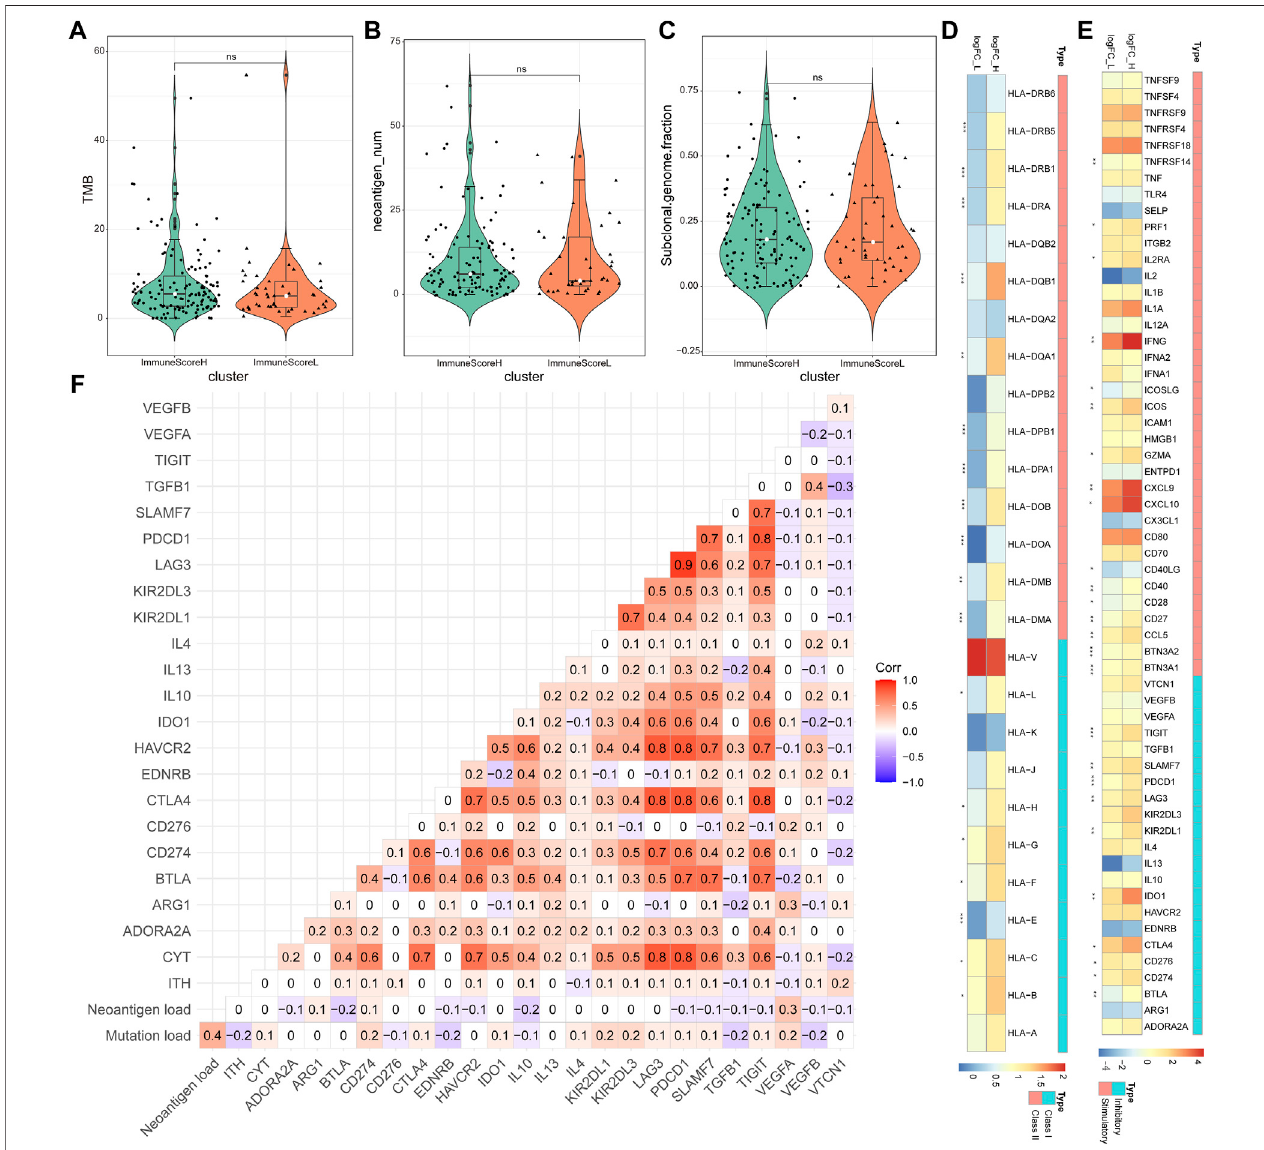
FIGURE 5 | Potential intrinsic immune escape mechanisms of BLCA. Comparison of TMB (A) , neoantigen load (B) , and ITH (C) between the two clusters. In the violin plots, the mean values are plotted as white dots, and the boxplot was drawn inside the violin plot. (D) Comparison of the log2 FCs in HLA molecule expression in ImmuneScoreH compared with ImmuneScoreL. (E) Signi fi cant differential expression of costimulatory and coinhibitory molecules between the two clusters ( p < 0.01). * p < 0.05, ** p < 0.01, *** p < 0.001. (F) Correlations between tumor immunogenicity indicators and the expression of immune checkpoint molecules.